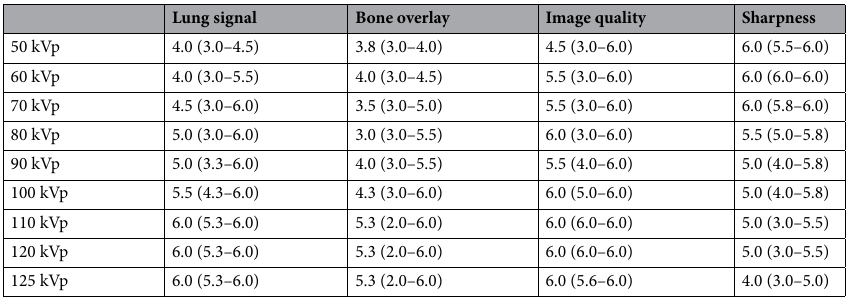
Table 2. Results of the reader study examining attenuation radiographs. All values are given in median (range) of the three readers after calculation the mean of their readings. The highest subjective lung signal and subjective image quality were found for high tube voltages. The highest sharpness scores were found for low tube voltages with the highest bone signal score at 50 kVp. Despite the high subjective bone signal, the rating for bone overlay (meaning how well the lung is visible despite the bone overly) only showed small differences between the tube voltages, ranging from a mean of 3.8 (at 50 kVp) to 5.3 (at 110–125 kVp).